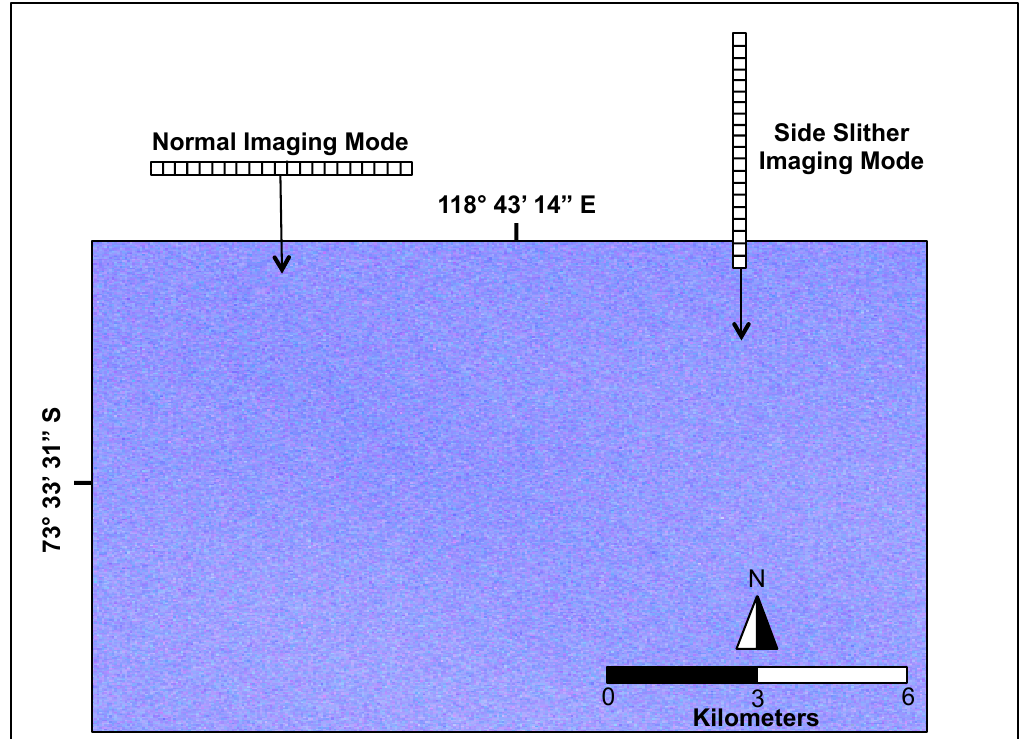
Figure 2. Illustration of a perfect linear array imaging over Dome Concordia, Antarctica in both normal imaging mode and side slither